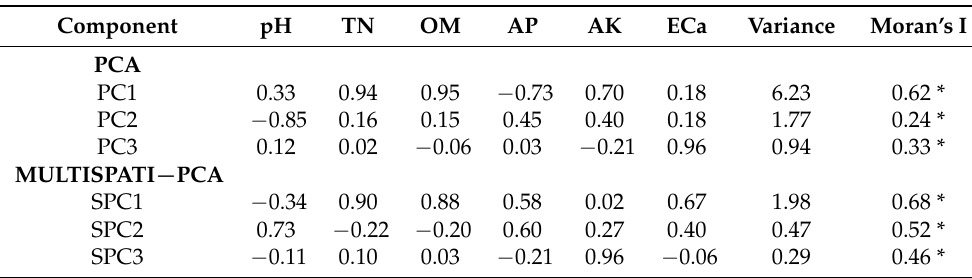
Figure 3. The eigenvalue and cumulative explained variance plots of principal component analysis (PCA) and multivariate spatial analysis based on Moran’s index PCA (MULTISPATI-PCA). ( a ): PCA; ( b ): MULTISPATI-PCA. The red line represents the eigenvalue equal to 1. Table 3. Loadings for the variables in the principal components (PCs) and spatial principal components (SPCs) and statistics of the PCs and SPCs.